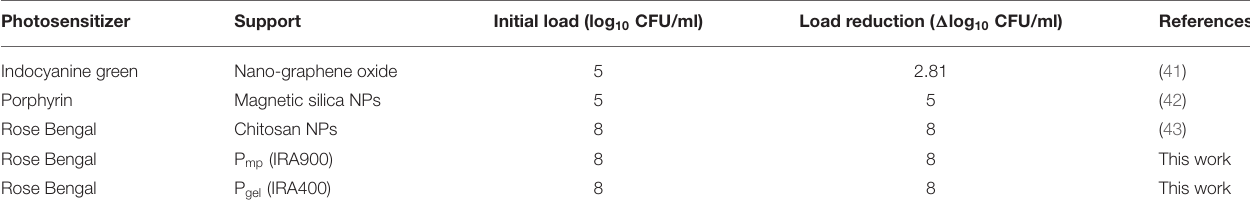
TABLE 1 | Representative examples reported in the literature of Enterococcus faecalis inactivation caused by photosensitizing materials.